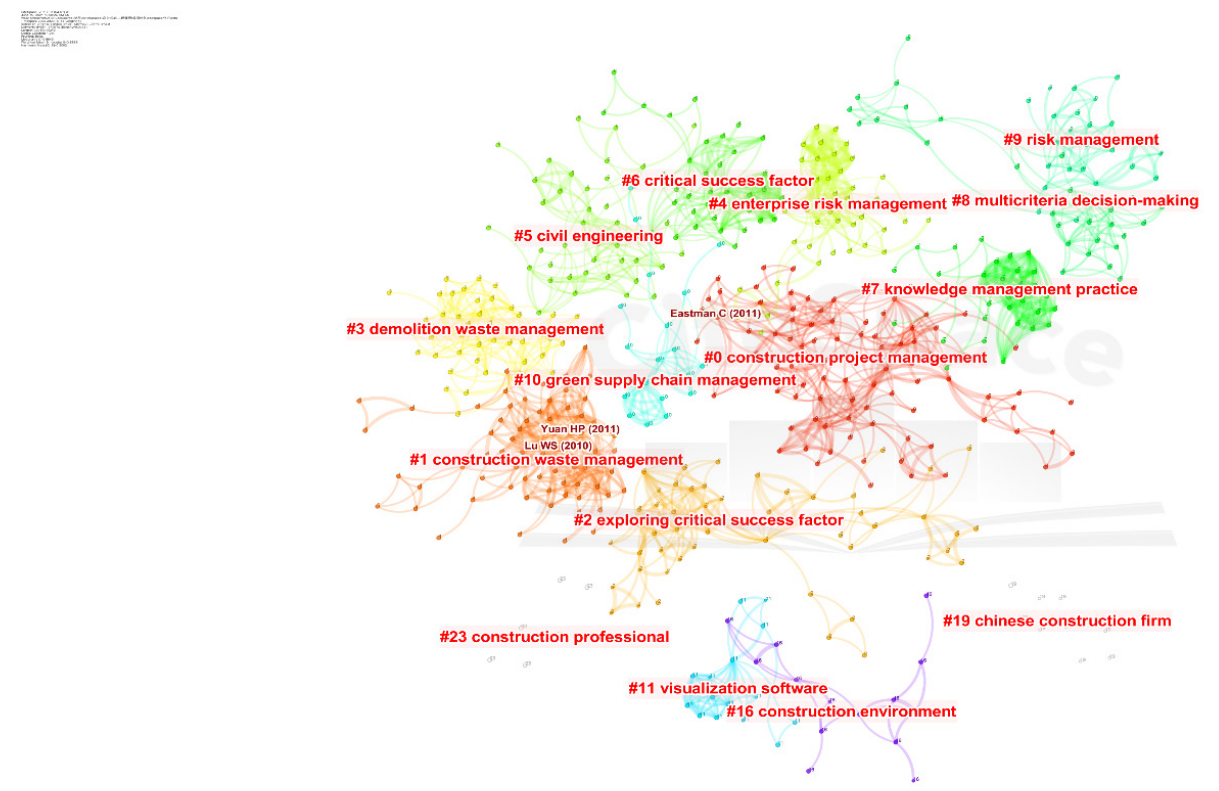
Figure 6. Cluster view of co-citation network of cited reference (generated by Citespace ). Table 4. Fifteen major clusters of co-cited